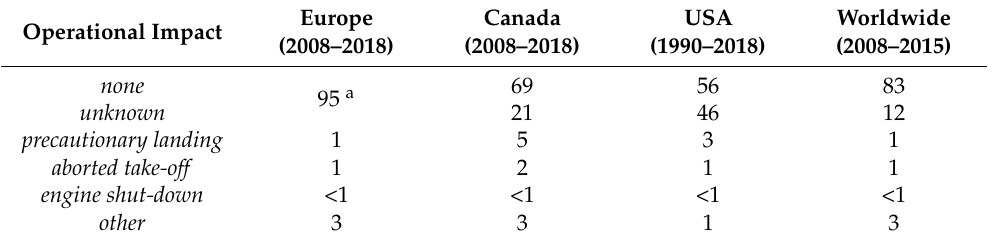
Table 2. Reported operational effects in Europe, Canada, the USA as well as world-wide in percentages [8,10,14,31].